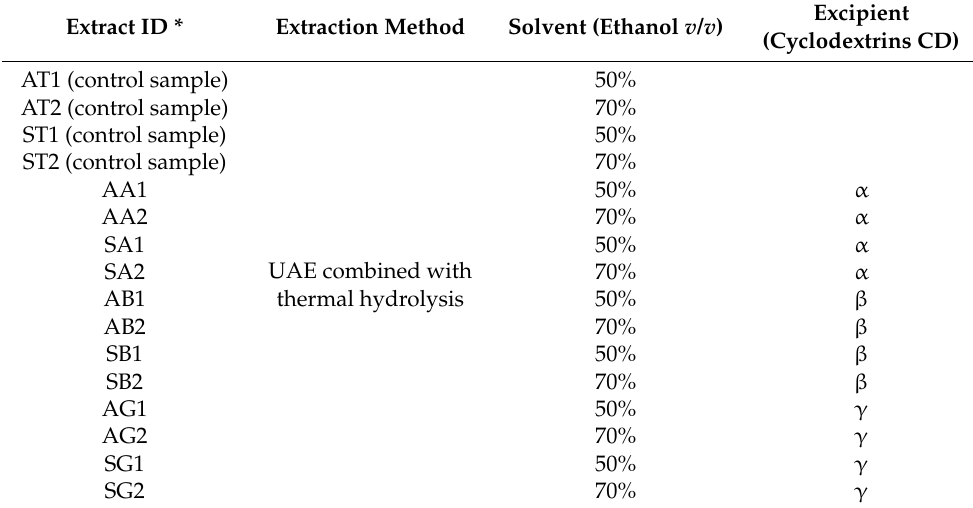
Table 1. Extract ID and preparation